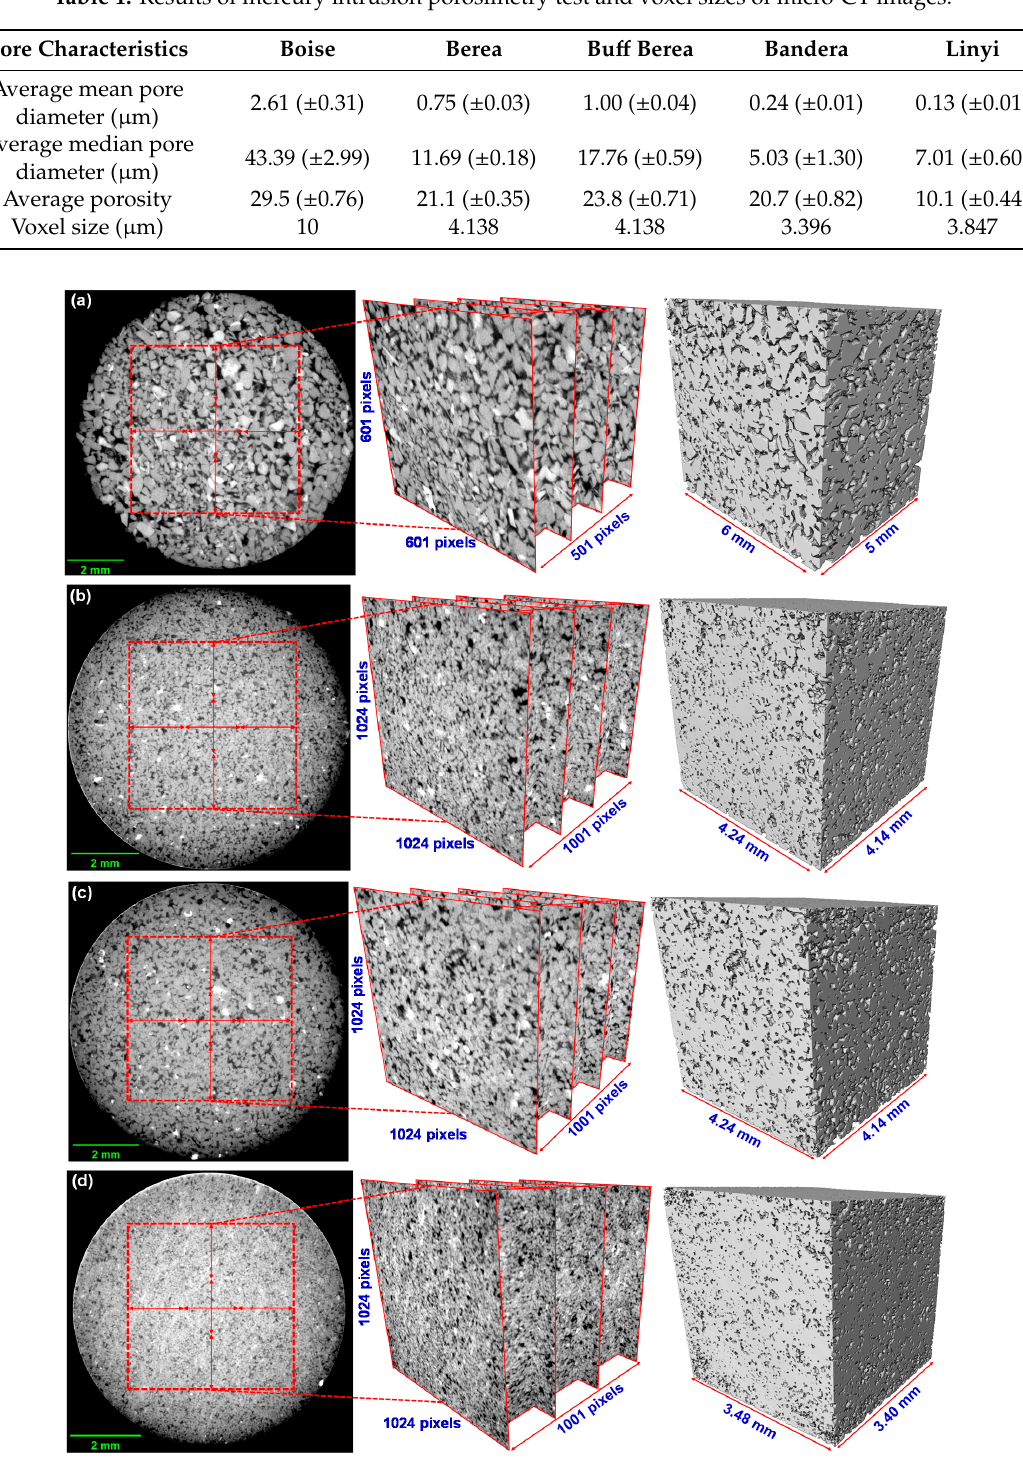
Table 1. Results of mercury intrusion porosimetry test and voxel sizes of micro-CT images.